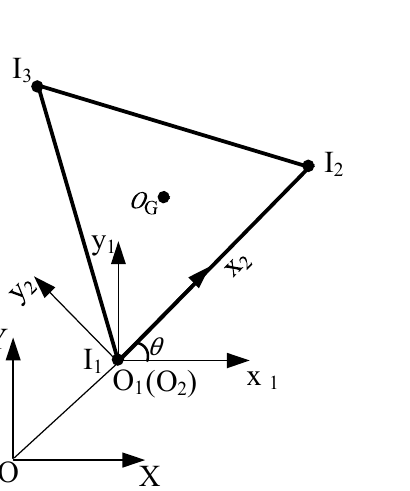
Figure 2. Mobile platform of PPM.